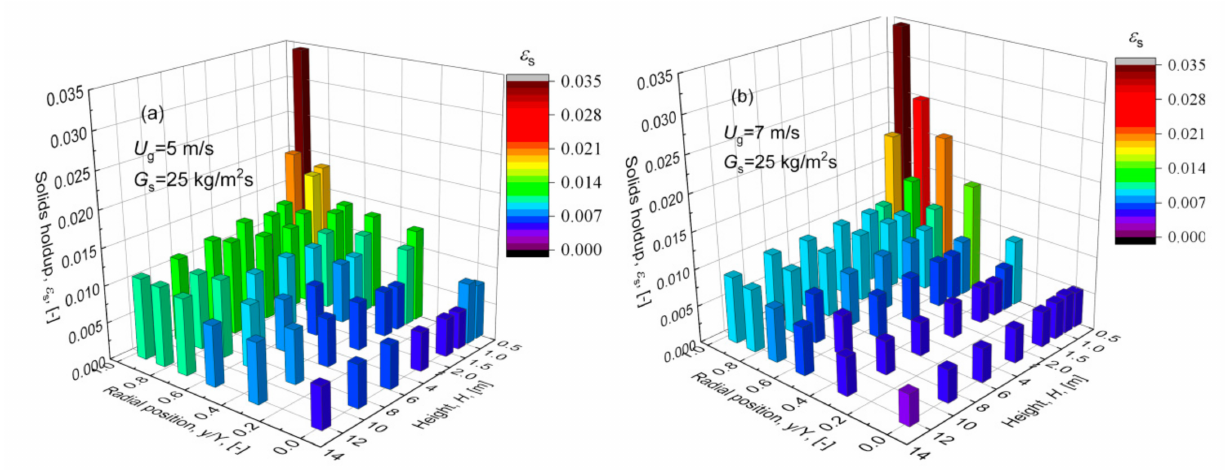
Figure 8. Three-dimensional diagram of the solids holdup with solids circulation rate of 25 kg/m 2 · s. (( a ) represents the distribution of solid holdup with U g = 5 m/s, G s = 25 kg/m 2 · s, ( b ) represents the distribution of solid holdup wtih U g = 7 m/s, G s = 25 kg/m 2 ·